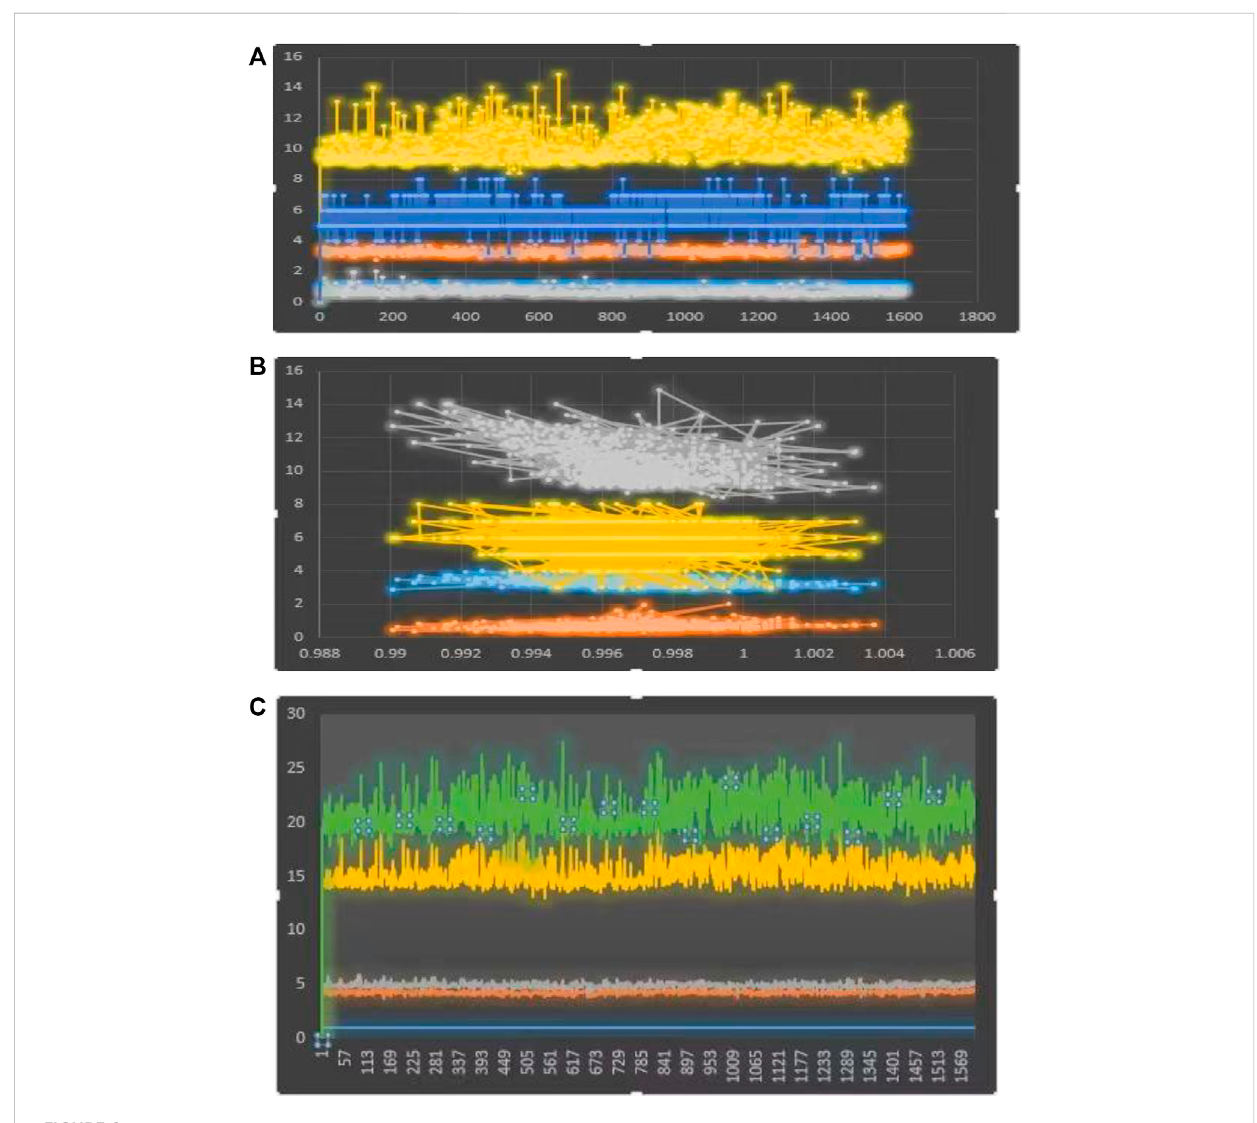
FIGURE 2 Differences in variations can be seen in Ref. ( A-C ) Signals variable parameters differences.